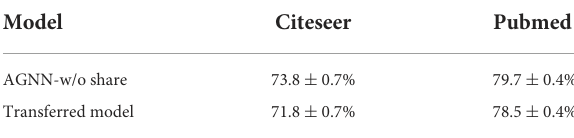
TABLE 6 Test performance comparison of the transferred architecture to the optimal ones on Citeseer and